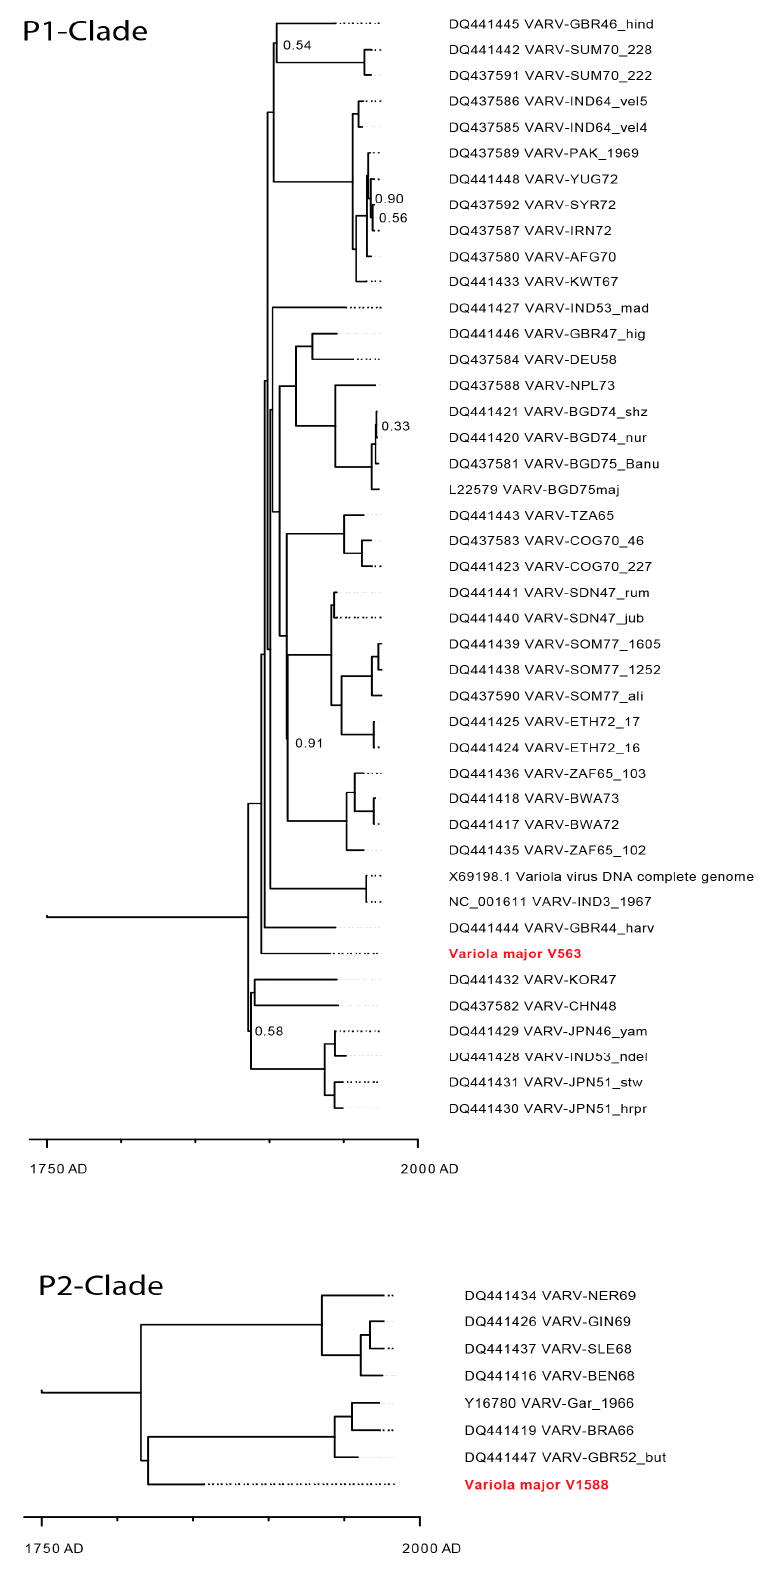
Figure 5. Maximum credibility tree for variola virus genomes, split into the major clades P-I and P-II. The chronogram was generated using BEAST software and is based on the highly conserved central genome region (104,142 bp). The posterior probabilities of all clades are >95% unless stated otherwise close to the nodes. Sequences of specimens V563 and V1588 are shown in red.